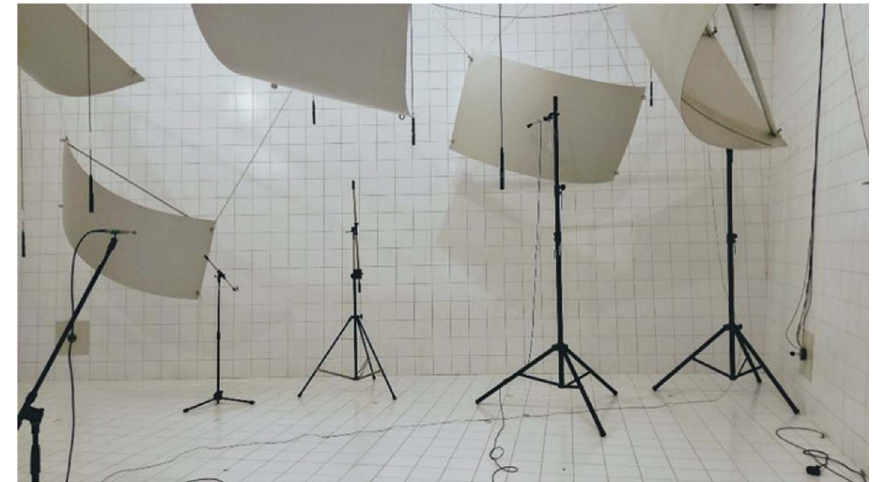
Figure 10. Measurement set up in a real reverberation chamber in the